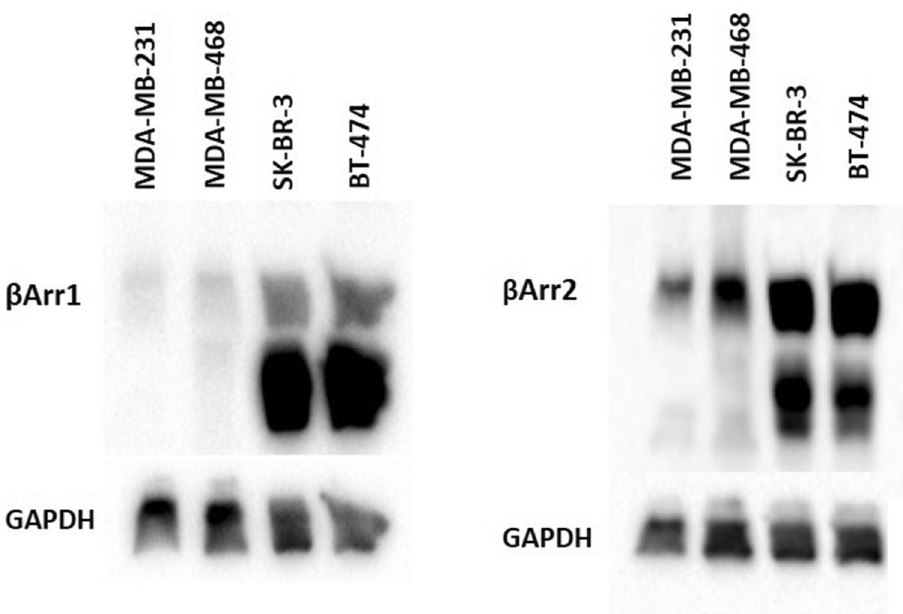
Figure 2. Expression of βArr1 or βArr2 in breast cancer cell lines. Representative Western-blot analysis of the expression of βArr1 or βArr2 from the cell lysate (30 µg/per lane) of the most aggressive breast cancer cell lines TNBCs (MDA-MB-231 and MDA-MB-468) and the less aggressive ones Her2-enriched (SKBR3) and Luminal B (BT474) was shown. The analysis showed a single band in MDA-MB-231 and MDA-MB-468 and two bands in SKBR3 and BT474. The second lower band in western-blot analysis in SKBR3 and BT474 is most probably related to splice variants of βArr1 and βArr2. The expression of both βArr1 and βArr2 was significantly less in TNBC cells (MDA-MB-231 and MDA-MB-468) than Her2-enriched, SKBR3, or Luminal B, BT474. The expression of βArr1 and βArr2 was significantly less in MDA-MB-231 than in